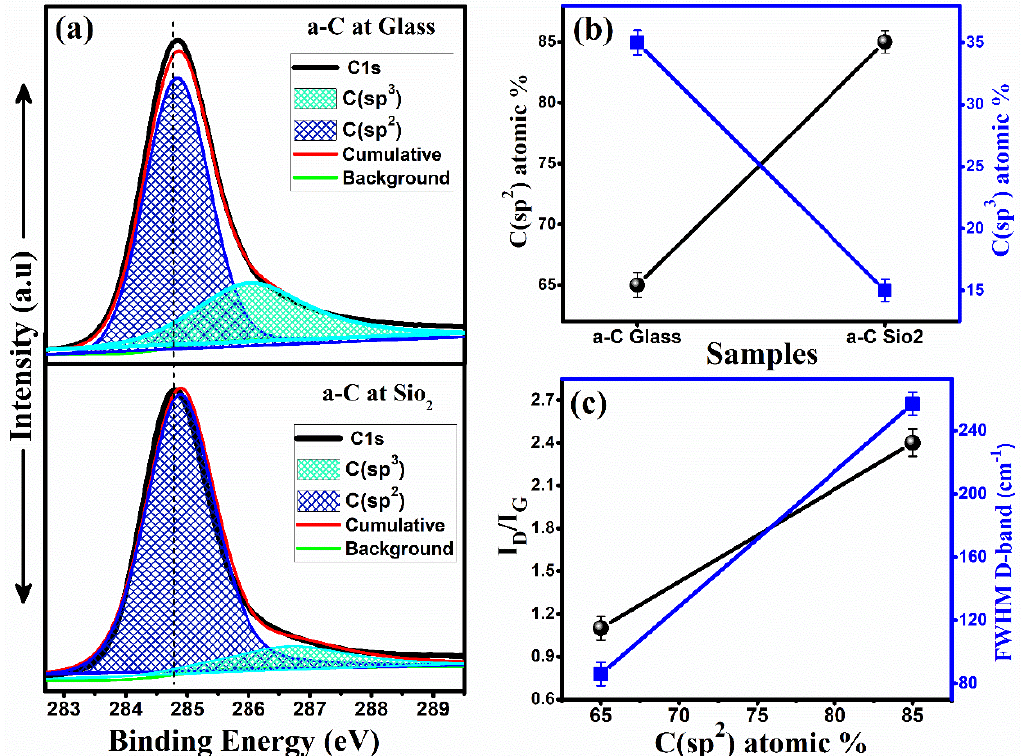
Figure 5. XPS spectra of sample a-Carbon ( a ) on a glass and SiO 2 substrate; ( b ) C( sp 2 ) and C( sp 3 ) ratio; ( c ) I D / I G ratio vs FWHM of the D-band.